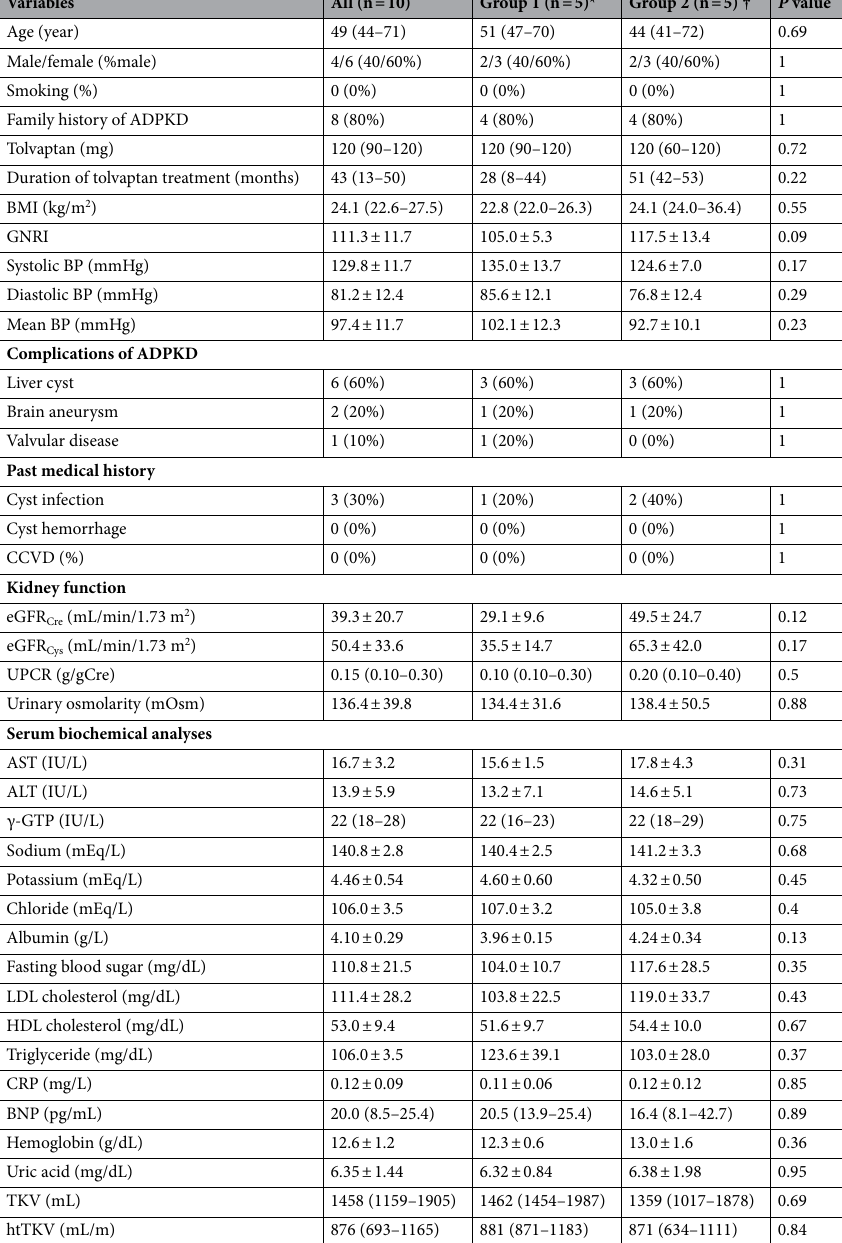
Table 1. Demographic, clinical, and biochemical data of the study groups. ADPKD autosomal dominant polycystic kidney disease, BMI body mass index, GNRI geriatric nutritional risk index, BP blood